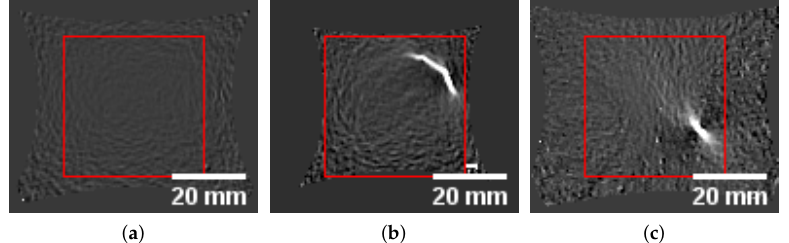
Figure 2. Varying images sizes depending on forming progression. Center cropped evaluation areas of DX54D and DP800 showing the extreme cases of the forming process: ( a ) DX54D-S245 homogeneous. ( b ) DX54D-S245 localization. ( c ) DP800-S245